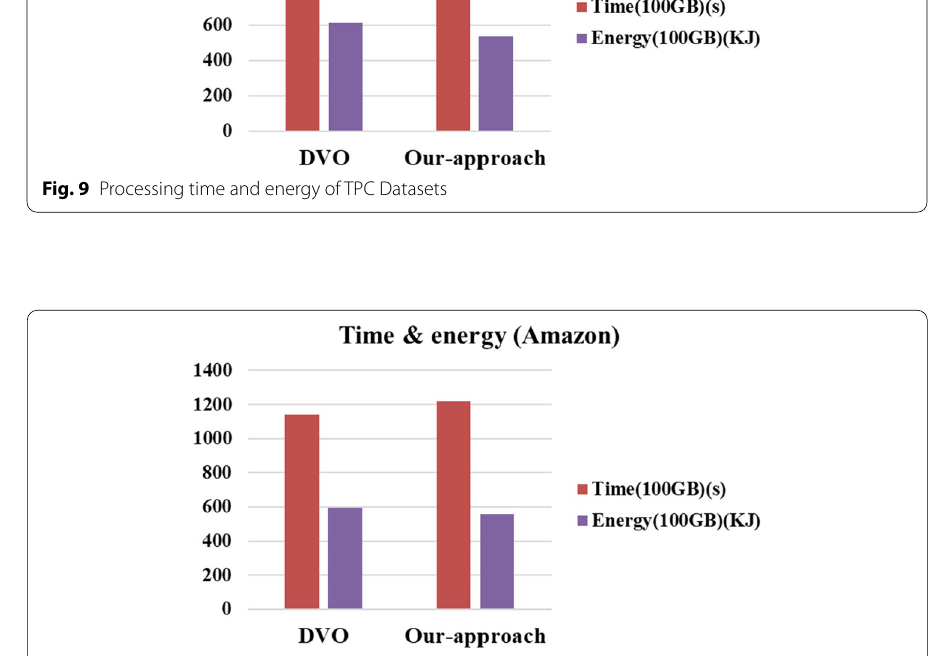
Fig. 10 Processing time and energy of Amazon